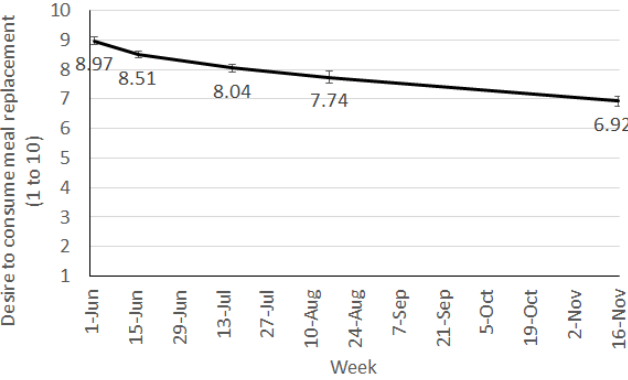
Figure 5. Adjusted means for desire to consume meal replacements.